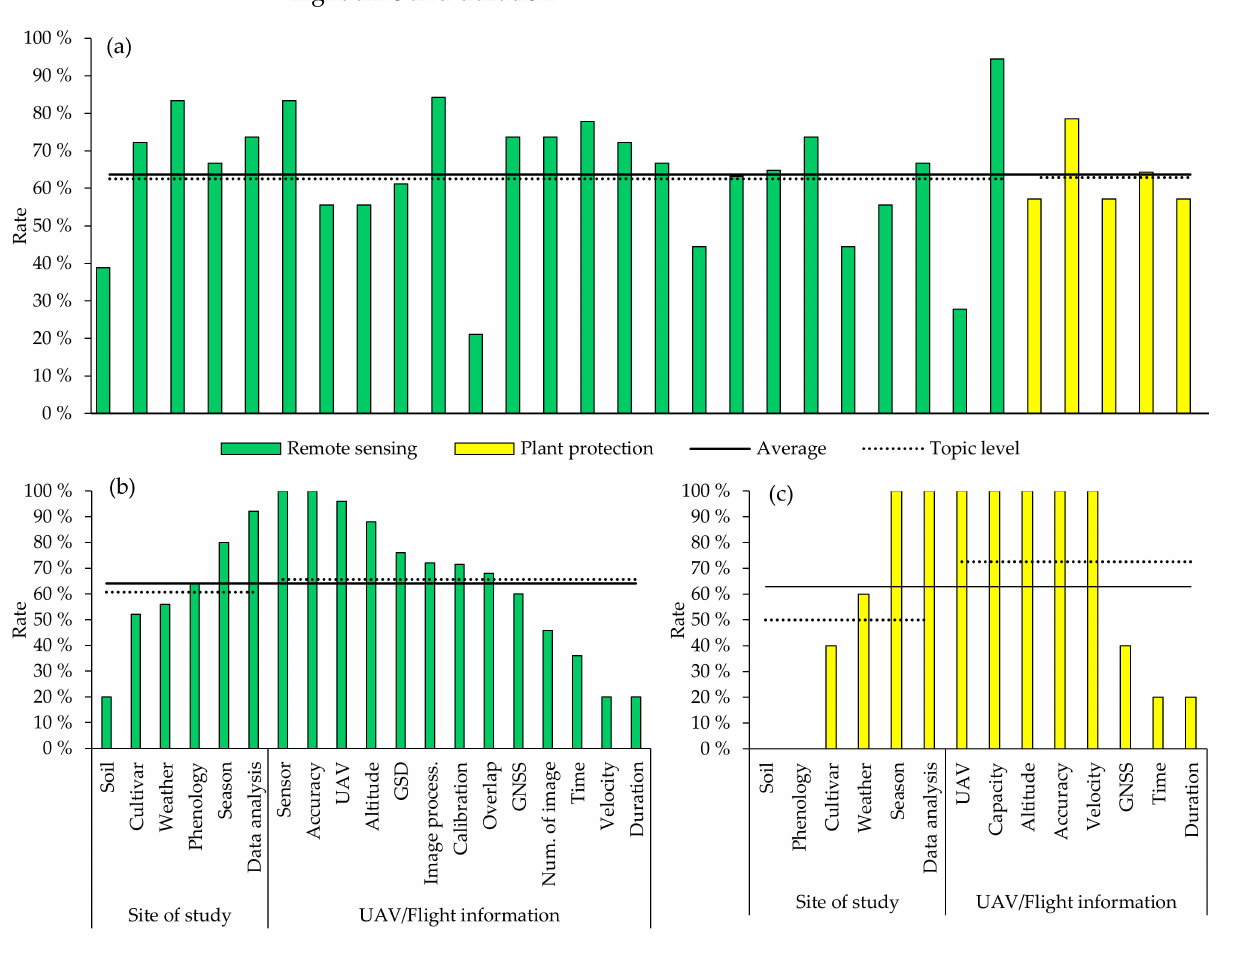
Figure 7. Soundness of research in UAVs for monitoring and managing sugarcane. ( a ) Overall quality for all full-text papers. ( b ) Quality of remote sensing papers by the empirical criteria. ( c ) Quality of plant protection papers by the empirical